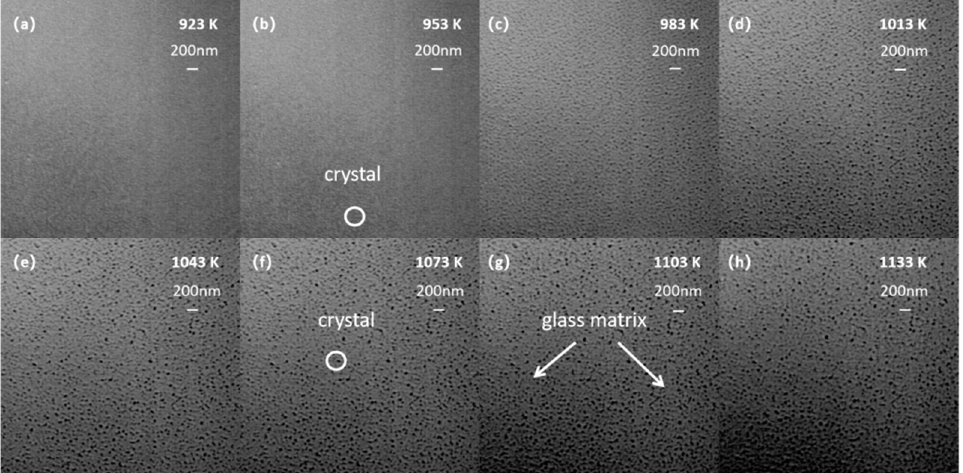
Figure 6. Images of Li 2 O–Al 2 O 3 –SiO 2 glass crystallization process. ( a ) Crystallization images at 923K; ( b ) Crystallization images at 953K; ( c ) Crystallization images at 983K; ( d ) Crystallization images at 1013K; ( e ) Crystallization images at 1043K; ( f ) Crystallization images at 1073K; ( g ) Crystallization images at 1103K; ( h ) Crystallization images at 1133K.